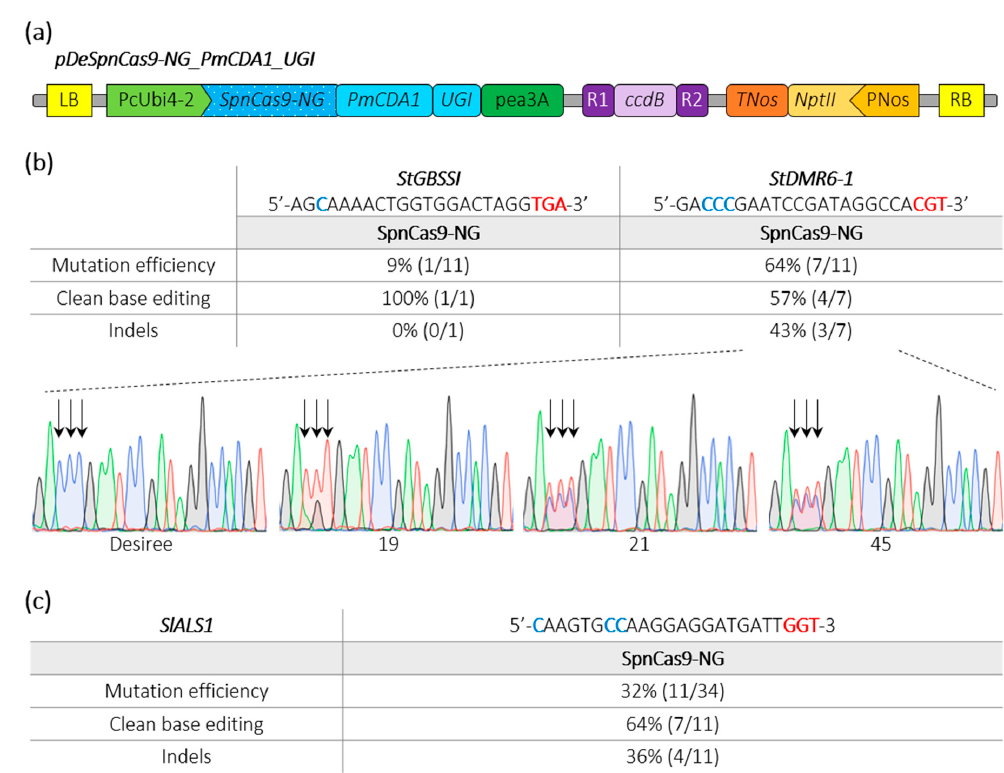
Figure 3. Schematic representation of a SpnCas9-NG cytosine base editing binary plasmid and editing efficiencies in potato and tomato. ( a ) The cytosine base editor construct used for Agrobacterium -mediated transformation of potato (Desiree) and tomato (WVA106) is schematically represented. ( b,c ) Edition efficiency represents the percentage of mutated plants among the transgenic plants. The modified cytosines observed in the edited plants are indicated in bold blue. Clean base editing refers to plants harboring substitution(s) without any detectable indels on Sanger chromatograms. The StDMR6-1 Sanger chromatograms for the control potato variety (Desiree) and three potato mutants harboring clean base editing are shown. The PAM sequence is depicted in bold red. Black arrows highlight the position of edited cytosines. A, T, C and G bases are represented in green, red, blue and black, respectively.